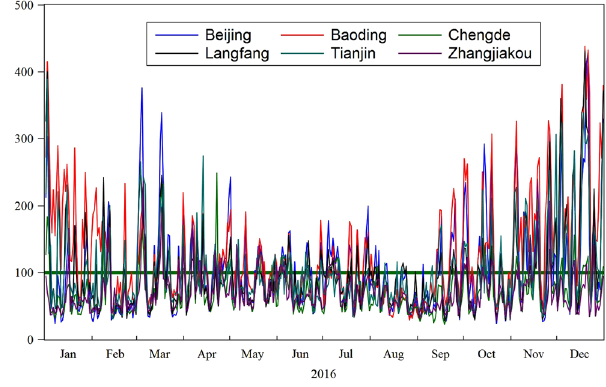
Figure 2. Daily AQI values of the 6 cities in 2016.